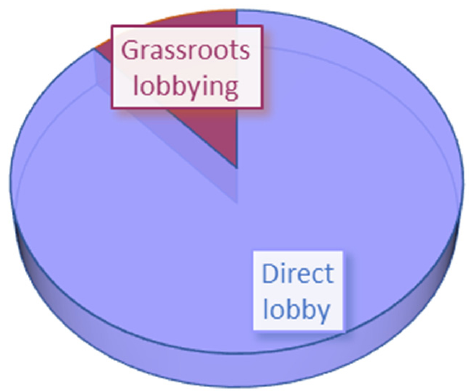
Figure 4. Distribution of the types of lobbying carried out by the lobbyists surveyed. Source: own elaboration.